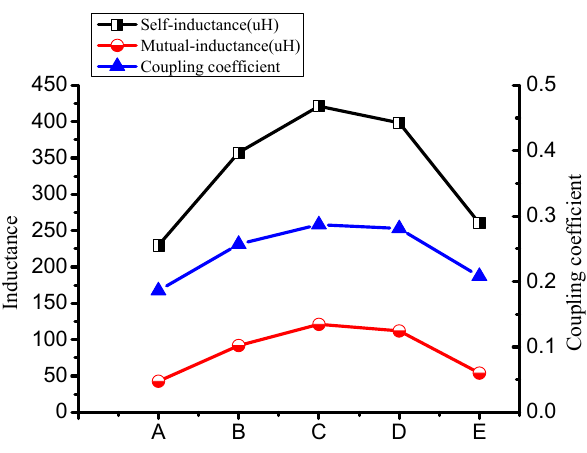
Figure 12. Self-inductance, mutual-inductance, and coupling coefficient of five different coils.